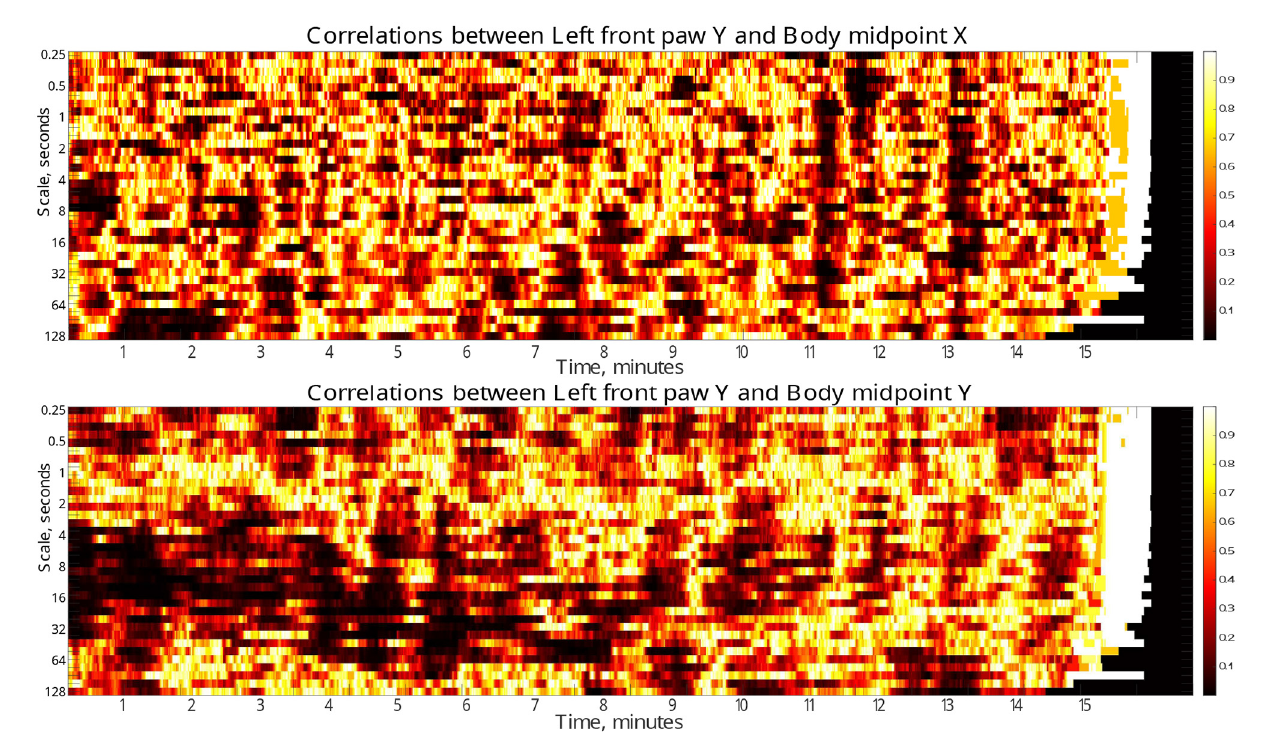
FIGURE6 Time-scale localization of discrepancies ( p -values) in the correlation dynamics of the left front paw (acting as a representative example) along the Y-axis relative to the animal body midpoint as a function of scale S between the test and the control animal groups. Compact dark areas indicate typical localization in the time-scale space where discrepancies can be observed. Discrepancies in the correlations with the animal body midpoint movements along the same Y-axis indicate presumable localization of discrepancies due to specific correlation patterns, while correlations with animal body midpoint movements along the orthogonal X-axis that one could expect to be unrelated, at least to a certain approximation, indicate the level of discrepancies caused by unspecific